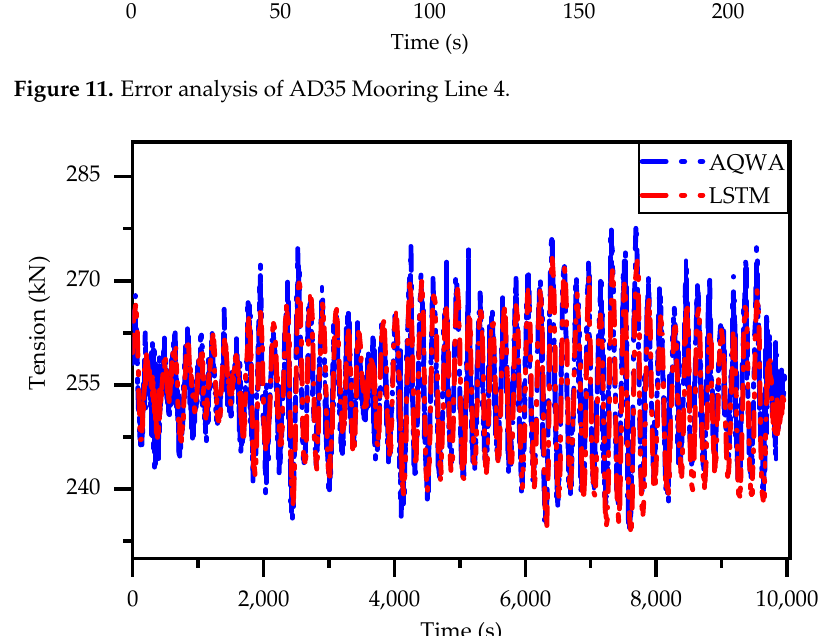
Figure 12. Time history curve comparison of AD32 Mooring Line 3.